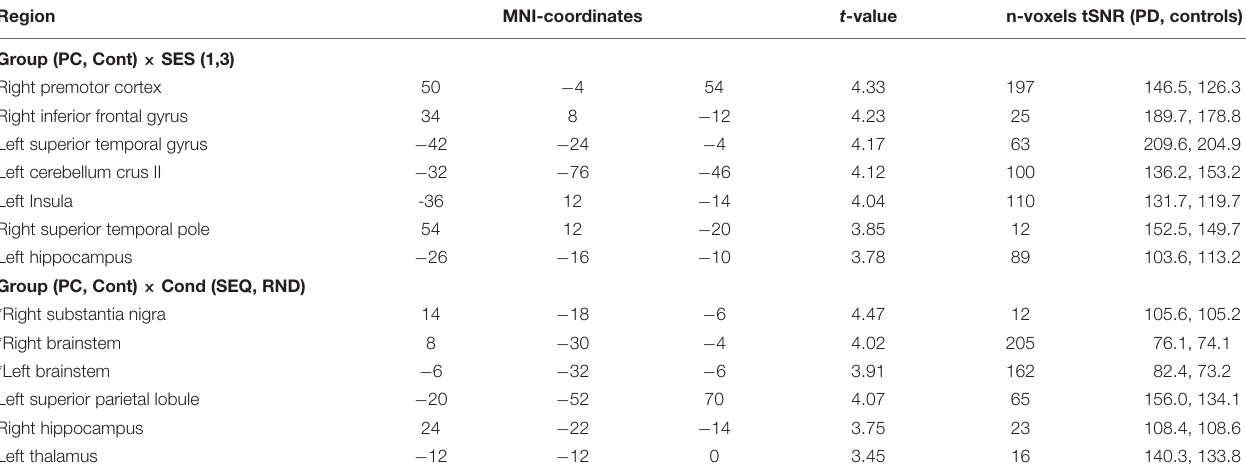
*p = 0.05, family-wise error corrected across the cluster.